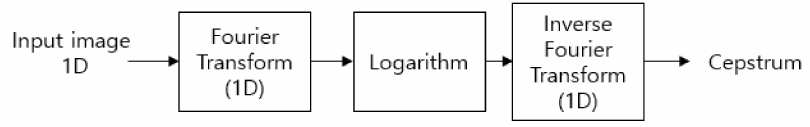
Figure 5. Cepstrum